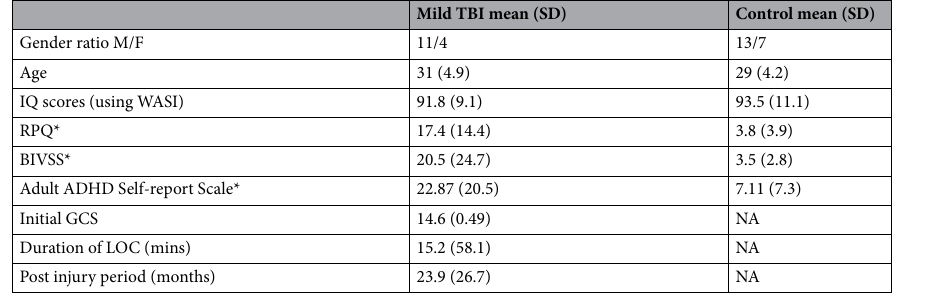
Table 1. Demographic characteristics for the control and mild TBI groups—M (SD). WASI-II The Wechsler Intelligence Scale, RPQ The Rivermead Post-Concussion Symptoms Questionnaire, BIVSS Brain Injury Vision Symptom Survey, GCS Glasgow Coma Scale, LOC loss of consciousness; *Indicates a significant difference between patients with mild TBI and controls (at an alpha of 0.05).